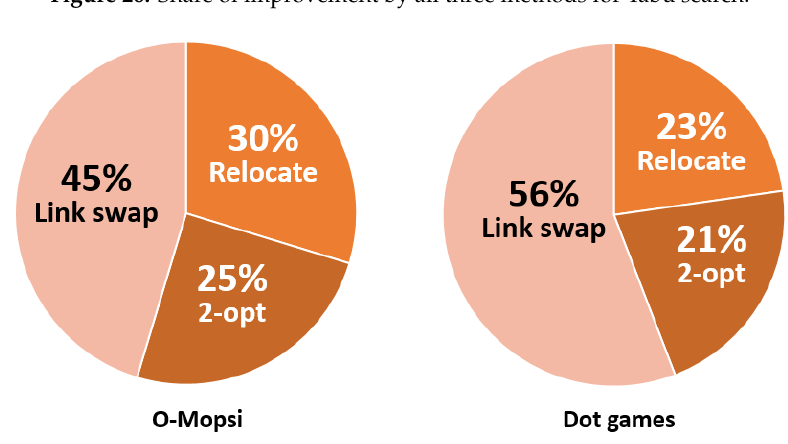
Figure 26. Share of improvement by all three methods for Tabu search.